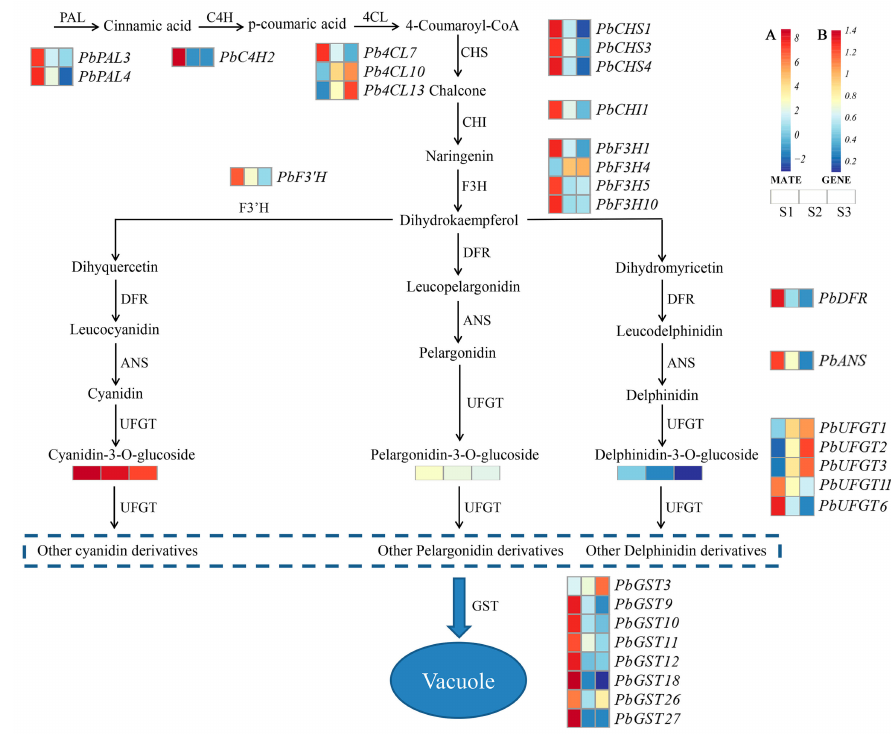
Figure 5. Reconstruction of anthocyanin biosynthetic pathways during leaf development using differentially expressed structural genes. ( A ) Anthocyanin levels at three developmental stages; ( B ) expression of differentially expressed structural genes at three developmental stages. PAL